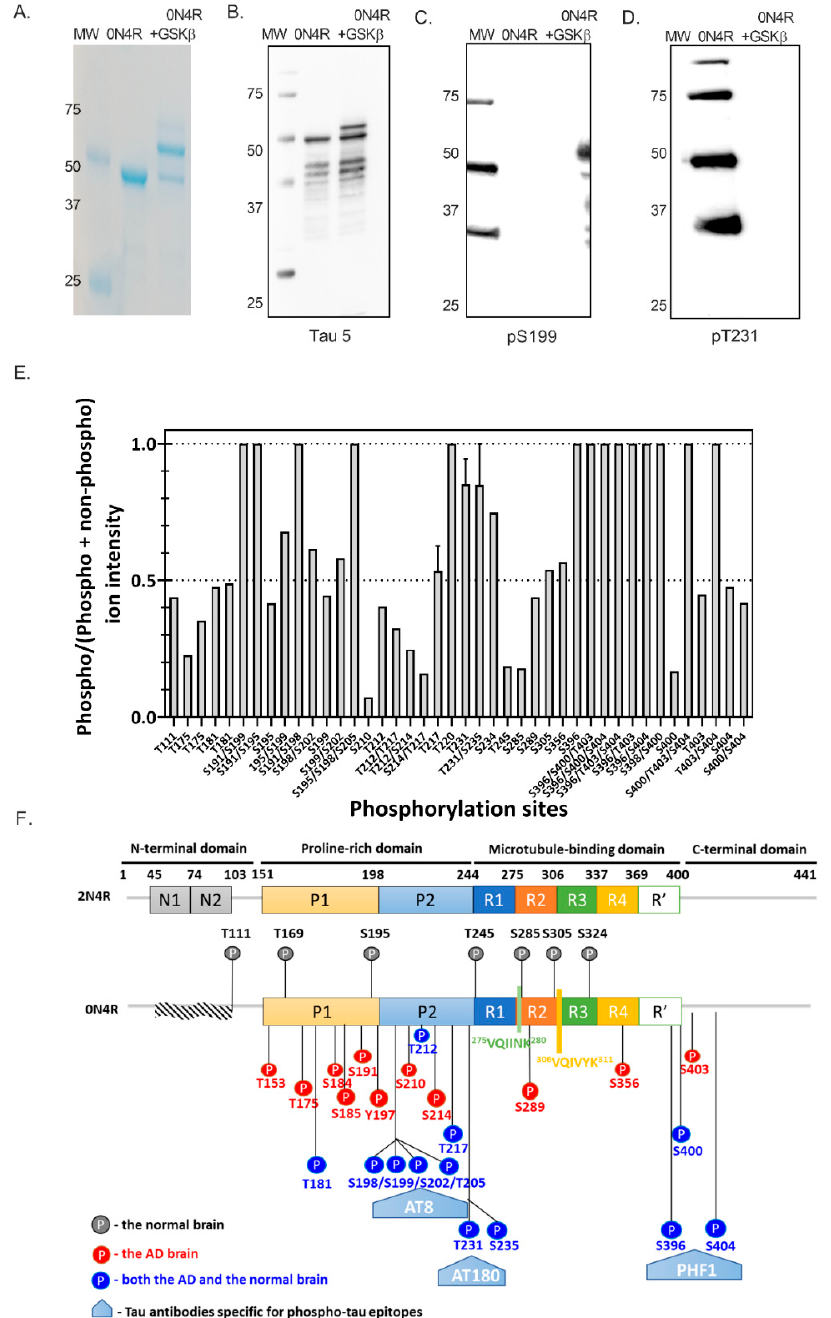
Figure 3. Co-expression of tau with GSK3 β phosphorylates 0N4R tau in E. coli . ( A ) Coomassie- stained SDS-PAGE of purified non-phosphorylated and phosphorylated tau (2 µg each). Western blot analysis using Tau-5 ( B ), anti-phosphoTau-S199 ( C ), and anti-phosphoTau-T231 ( D ) antibodies. Protein Western C ladder (Bio-Rad) standards are indicated (kDa). ( E ) Quantitative analysis of phosphorylation at 29 phosphorylation sites, as determined by LC-MS/MS analysis of purified phosphorylated tau (n = 2). ( F ) Schematic illustration of 29 phosphorylation sites on tau protein and epitopes specific for major tau antibodies. Red color denotes amino acids phosphorylated in the AD brain, blue in both AD and normal brain, and grey in the normal brain. Tau antibodies AT8, AT180, and PHF-1 specific for phospho-tau epitopes are shown in white letters, in a shape colored with light blue: AT8 (pSer202 and pThr205), AT180 (pT231), and PHF-1 (pSer396 and pSer404). The residues are numbered based on the amino acid designations for the full-length tau isoform, 2N4R.